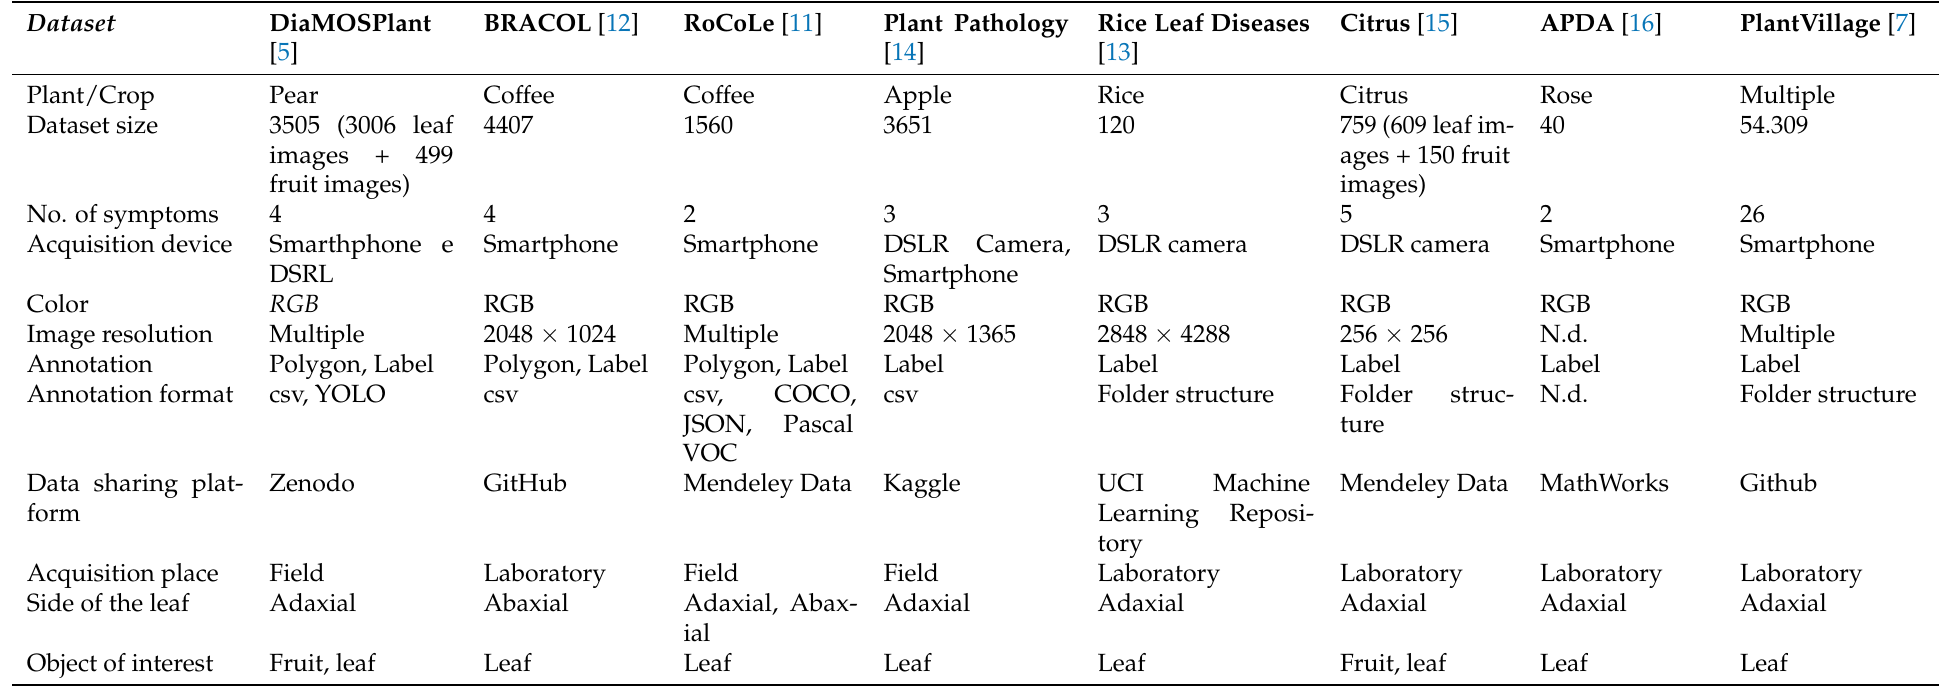
Table 6. Details of examined